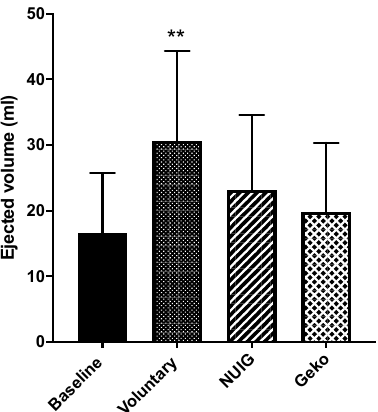
Figure 4. The effect of the intervention on the ejected volume (mL). The ejected volume was only significantly increased in voluntary ( n = 24). The NUIG ( n = 12) and Geko device ( n = 9) showed no significant change (** P < 0.001 versus baseline). Data shown as ± SD.